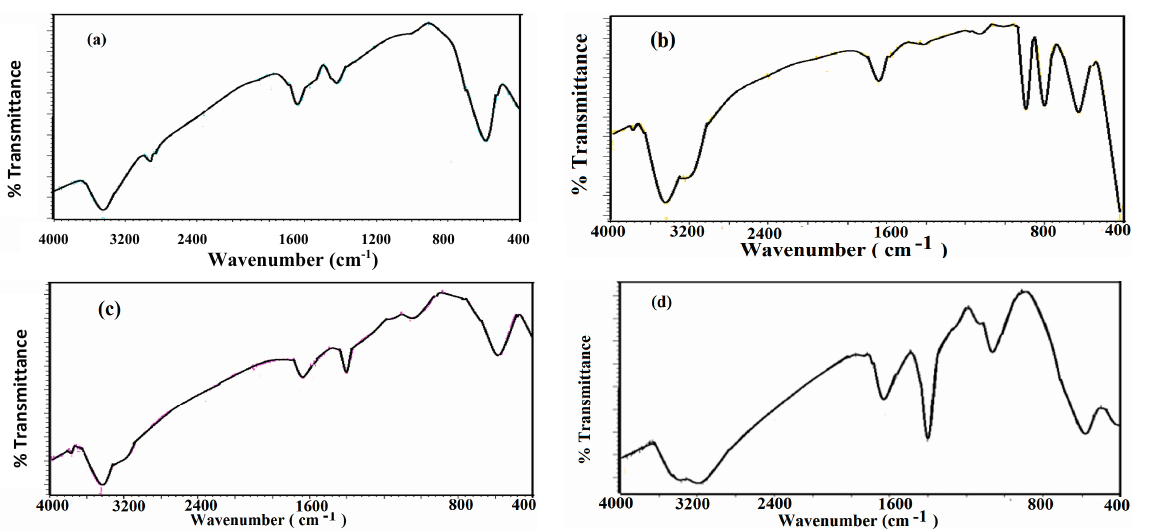
Figure 1. FTIR spectra of the prepared magnetite ( a ) absence of iodine; ( b ) presence of iodine; ( c ) presence of myrrh; and ( d ) presence of myrrh and